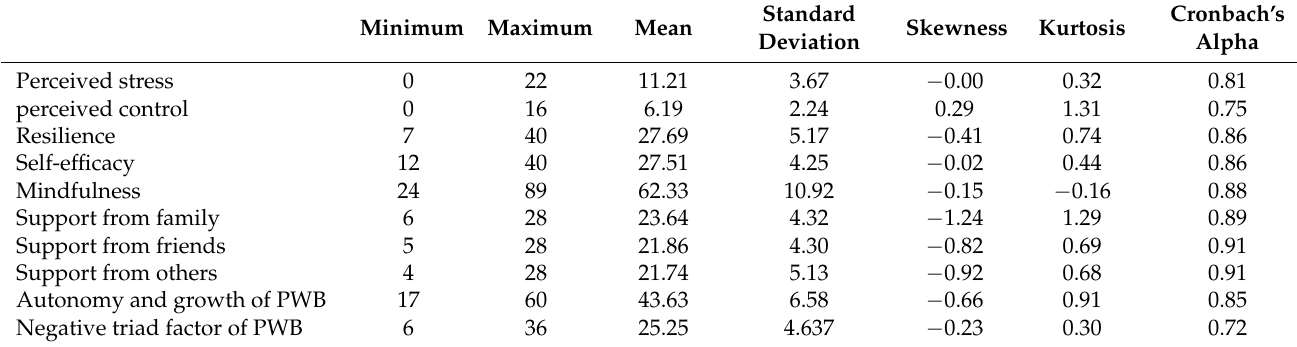
Table 2. Description of study variables for Thai sample (n = 966).